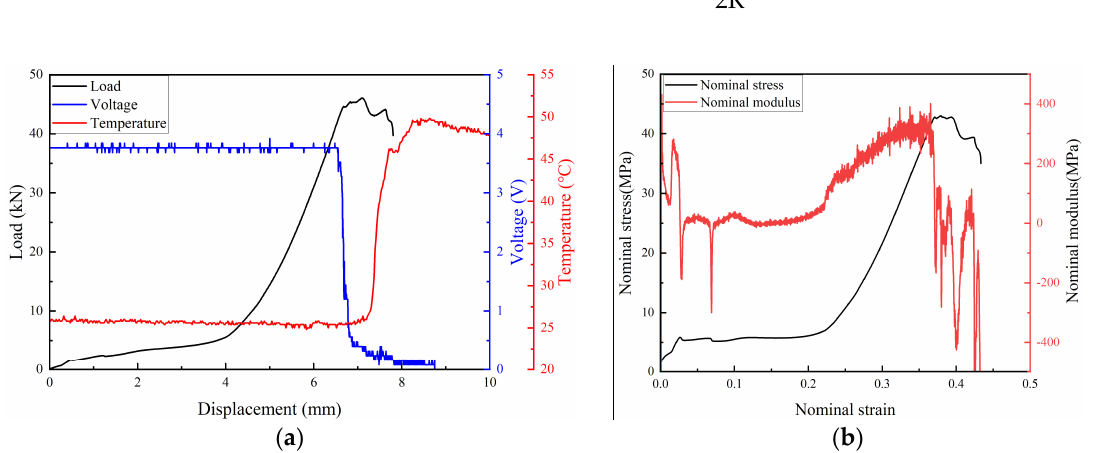
Figure 4. Loading curve of Li-ion battery: ( a ) load, voltage, temperature–displacement curve; ( b ) nominal stress, nominal modulus–nominal strain